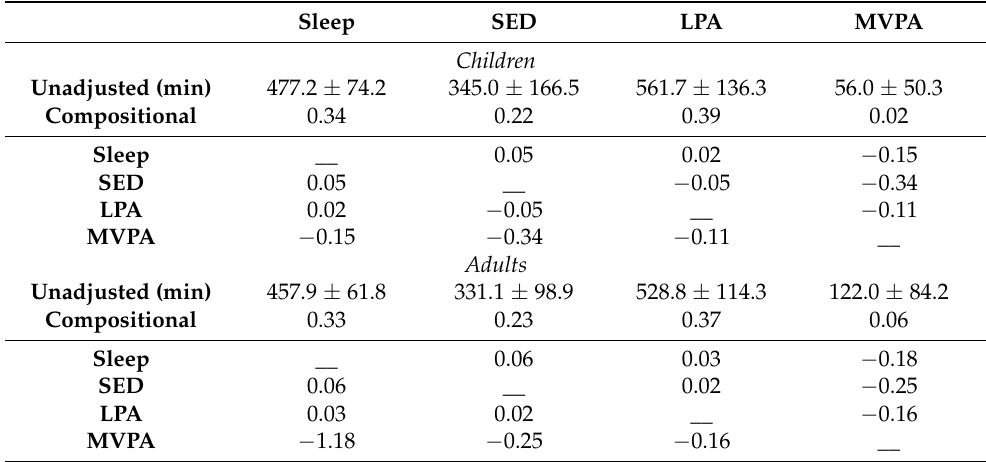
Table 2. Unadjusted and compositional means and variation matrix of movement behaviours in children and adults with CF. Sleep